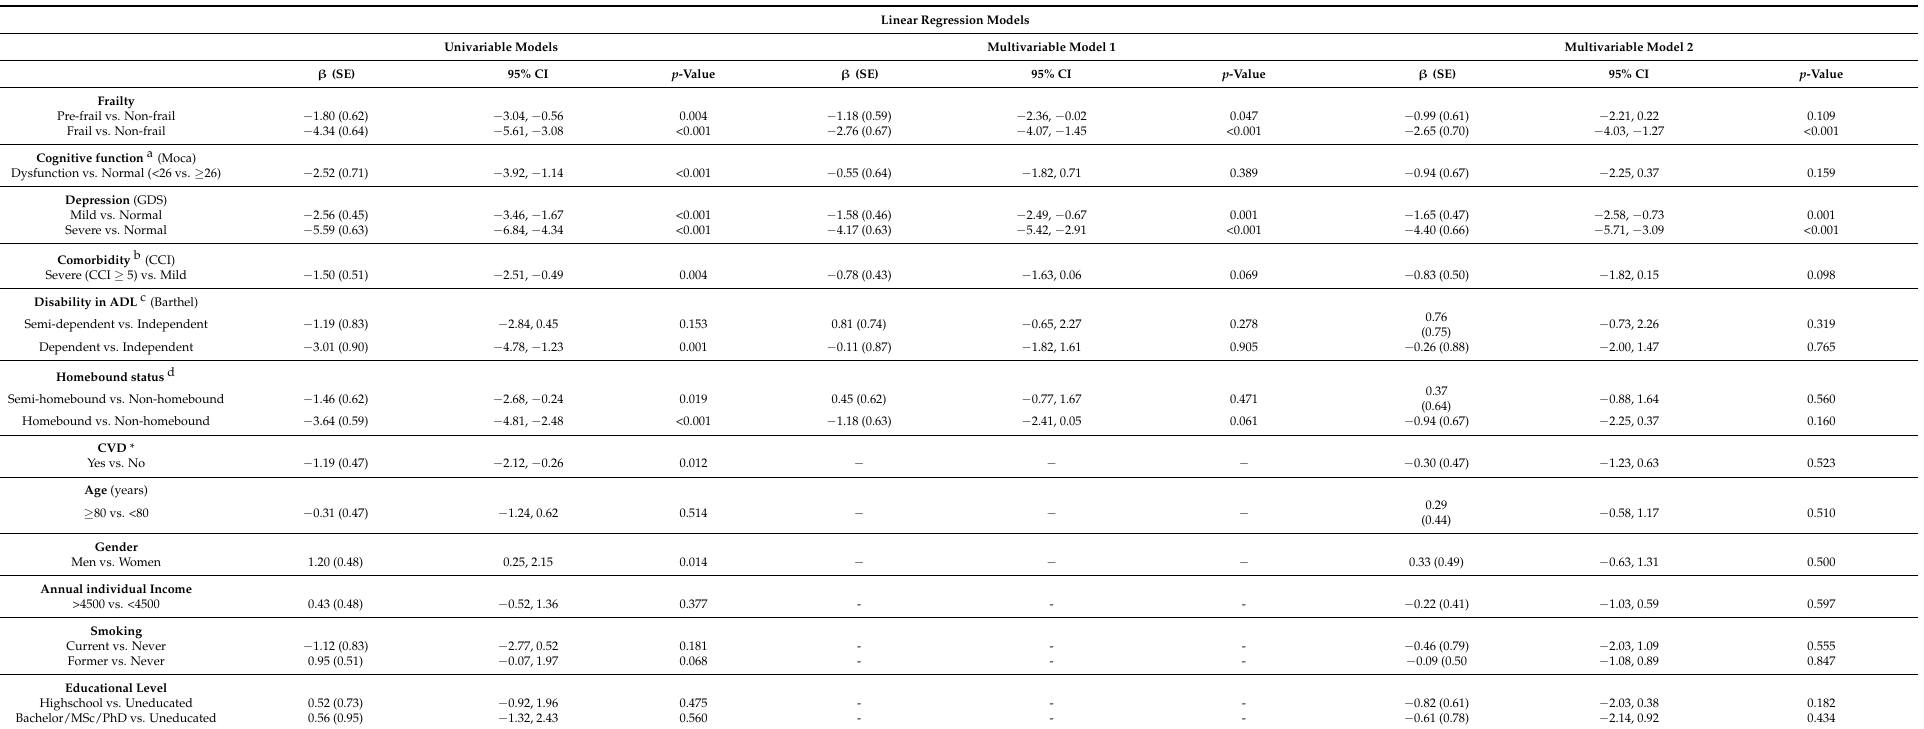
Table 3. The effect of frailty, geriatric syndromes, and demographic characteristics on Overall QoL.